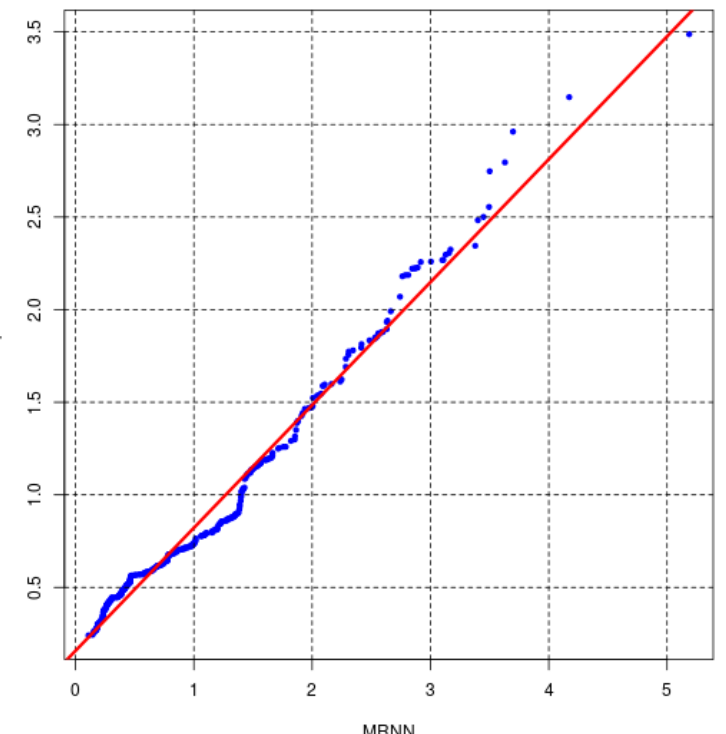
Figure A11. QQ plot between MRNN and Prophet on dataset Callcenter with quality measure MASE overall horizons.